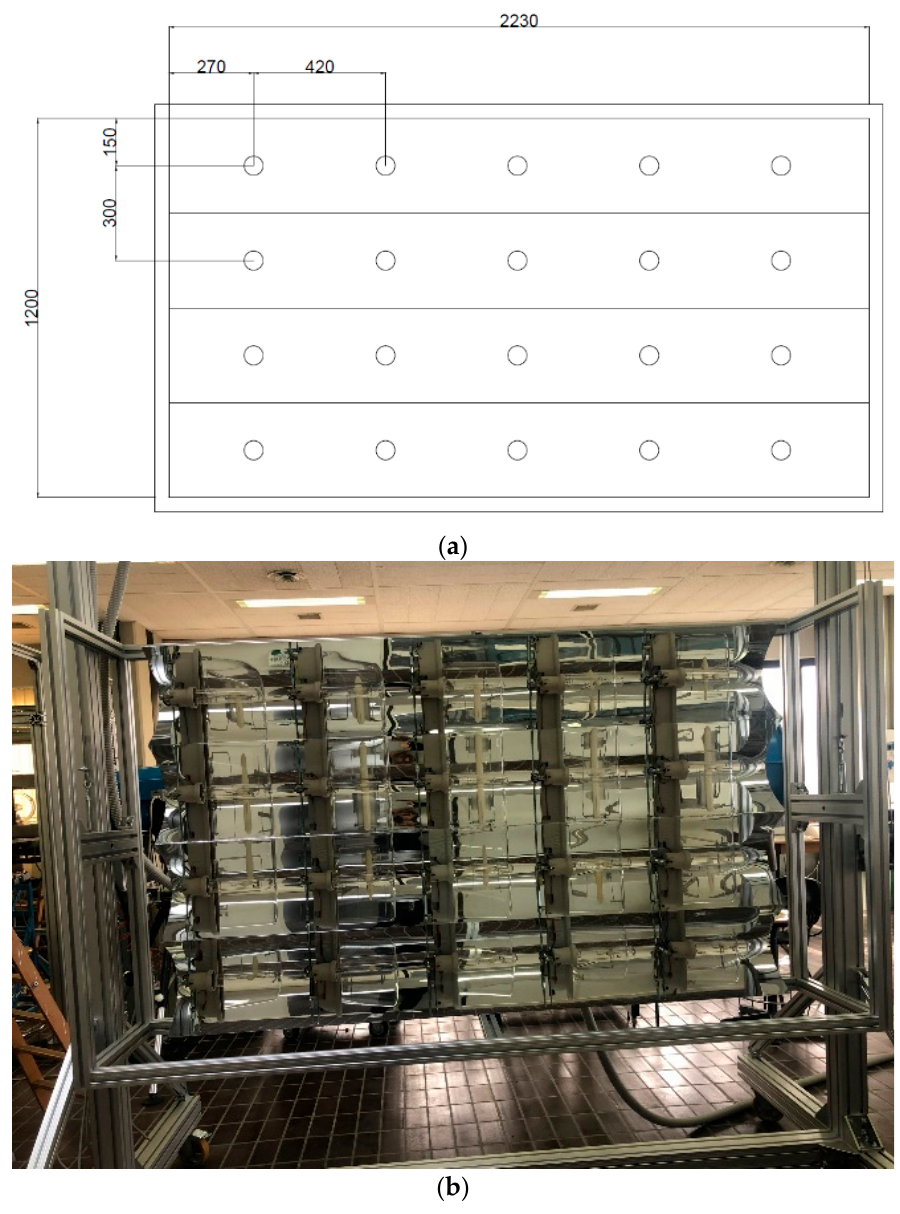
Figure 3. Lamp array size. CAD reconstruction (mm) ( a ) and real image ( b ). The lamp system is mounted on a structure made of aluminum profiles. The parab ‐ olas were glued on specially shaped wooden boards and mounted on the aluminum struc ‐ ture (Figure 4a). The system is equipped with a vertical guide to adjust the lamp–target distance and vary the intensity of the simulated radiation. It can also rotate to simulate an incident radiation not perpendicular to the plane (Figure 4b). Figure 4 depicts the 3D CAD reproduction.